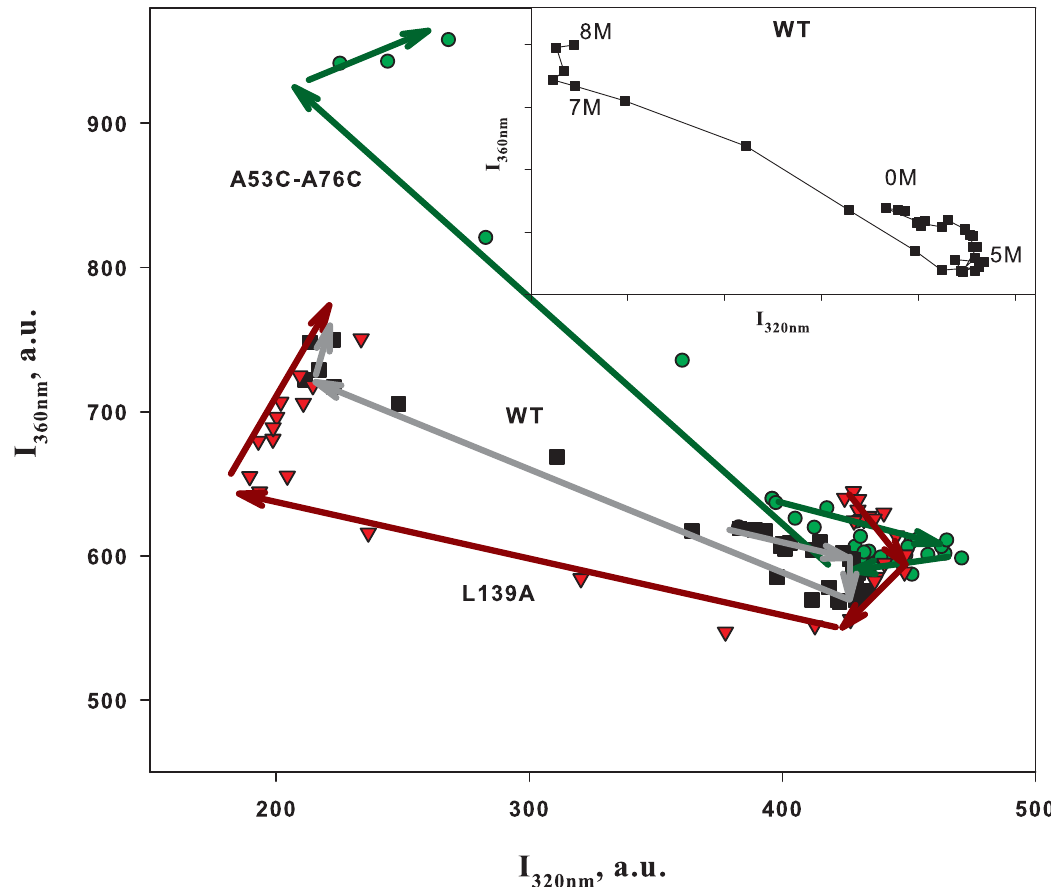
Fig 2. Phase diagram analysis of urea-induced unfolding of BCA II. Interdependence of fluorescence intensities at 320 and 360 nm for wild-type BCA II ( ■ WT) and its two mutant forms ( ▼ L139A and ● A53C-A76C) measured at different urea concentrations. Excitation at 280 nm. Arrows show the increase in urea concentration and accordingly the sequence of protein unfolding. Insertion: The dependence for the wild-type protein (WT) is shown with indication of urea concentrations in “key” points of the